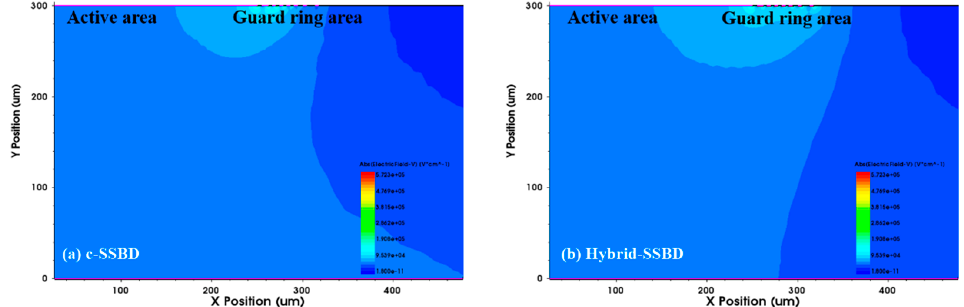
Figure 5. The electric field distribution of the ( a ) c − SSBD and ( b ) Hybrid − SSBD devices at a reverse bias of 1500 V. The stronger electric field is concentrated on the edge of the active area for c − SSBD, but more homogenously distributed on the guard rings for Hybrid − SSBD.